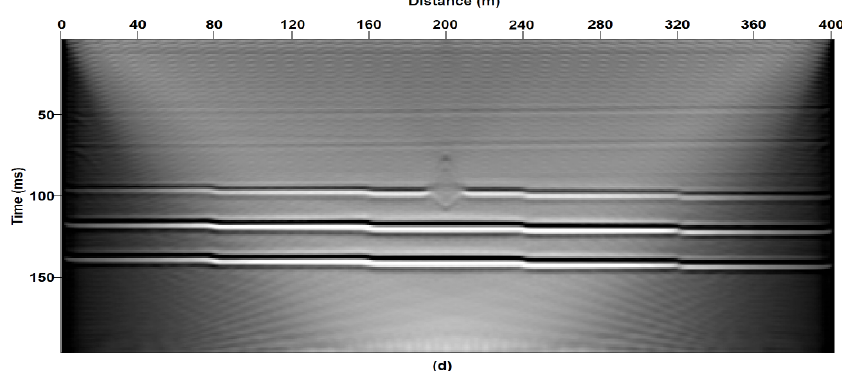
Figure 7. Numerical imaging results: ( a ) input velocity model of the negative acoustic variant with the pockmark model; ( b ) RTM image of ( a ); ( c ) input velocity model of the positive acoustic variant with the pockmark model; ( d ) RTM image of ( c ).